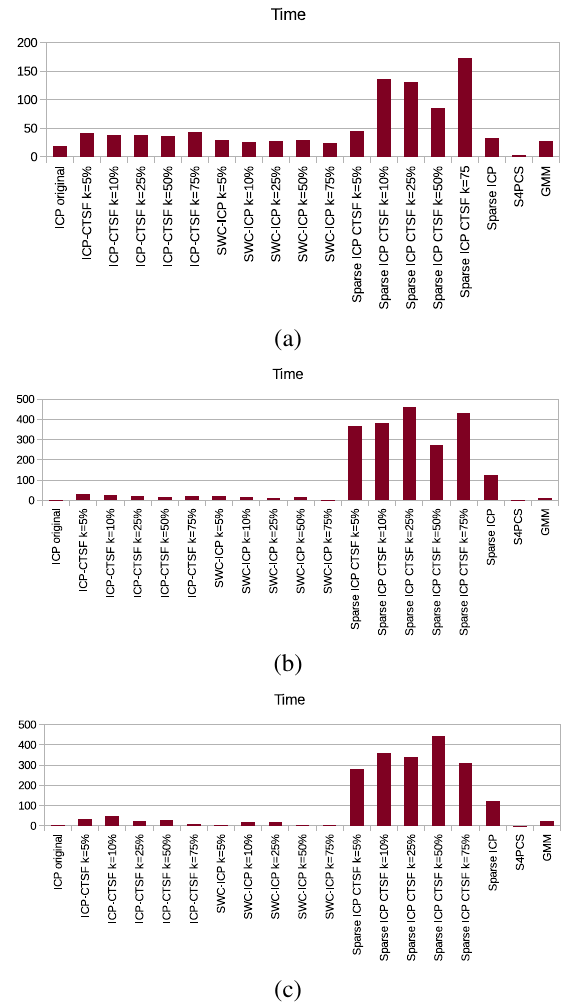
Fig. 10: CPU time in seconds obtained for each method when computing alignment for: (a) 0 ◦ - 45 ◦ . (b) 45 ◦ - 90 ◦ . (c) 90 ◦ - 180 ◦ .